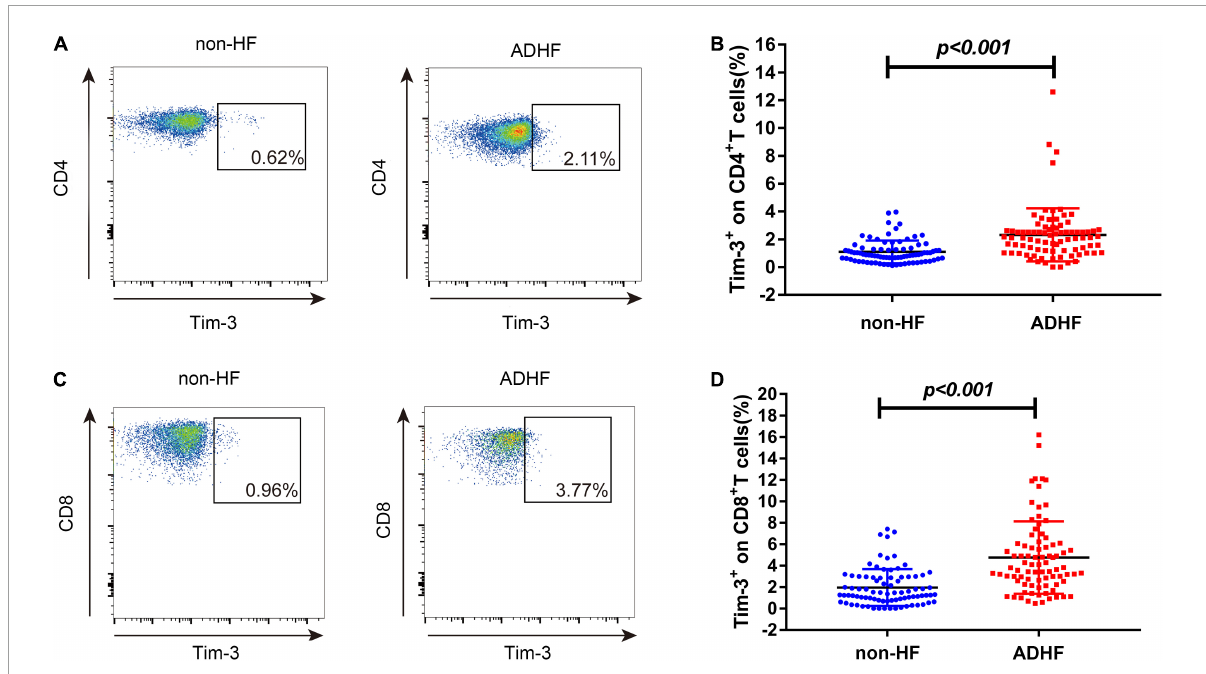
FIGURE2 The expression of Tim-3 on CD4 + T cells and CD8 + T cells in non-HF and ADHF groups. Peripheral blood mononuclear cells (PBMCs) were isolated from ADHF group ( n = 84) and the non-HF group ( n = 83). (A) Flow cytometry analysis of Tim-3 expression on CD4 + T cells. (B) The statistical graph of Tim-3 expression on CD4 + T cells is shown for ADHF group [ n = 84, 2.08% (1.15–2.67%)] and non-HF group [ n = 83, 0.88% (0.56–1.39%)]. (C) Flow cytometry analysis of Tim-3 expression on CD8 + T cells. (D) The statistical graph of Tim-3 expression on CD8 + T cells is shown for ADHF group [ n = 84, 3.81% (2.24–6.03%)] and non-HF group [ n = 83, 1.36% (0.76–3.00%)].